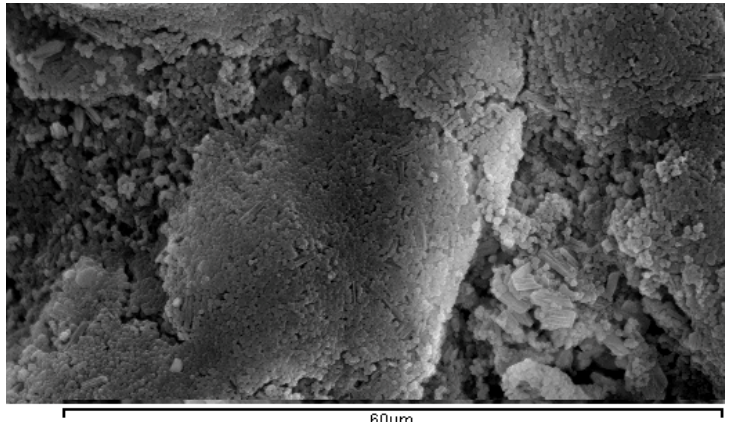
Figure 1. SEM image of Irgarol-loaded poly(lactic acid) (PLA) nanoparticles. Table 3. Size (PS), size distribution (PdI), zeta potential ( ζ -P) and encapsulation efficiency (EE) values of the prepared PLA particles.